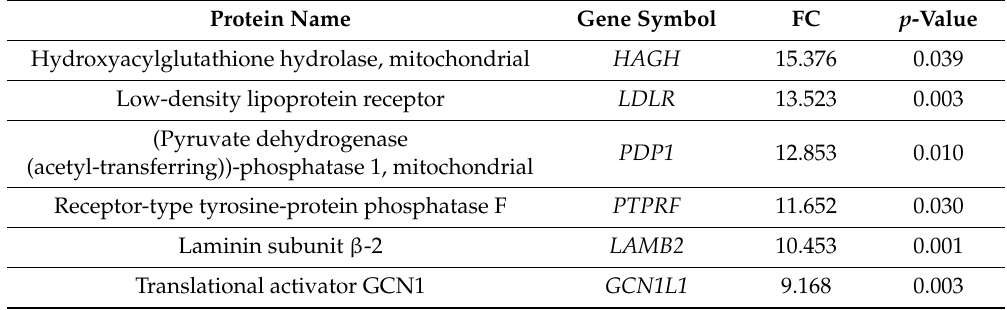
Table 1. Significantly upregulated proteins in human fetal retinal pigment epithelial cells (RPE) cultured in Dulbecco’s Modified Eagle’s Medium (DMEM) with 1% sericin compared to cells cultured in DMEM without sericin, sorted by decreasing fold change (FC). FC was calculated as follows: FC = ((mean of protein expressions in RPE cultured in DMEM with 1% sericin) / (mean of protein expressions in RPE cultured in DMEM without sericin)). N = 3. FC: Fold